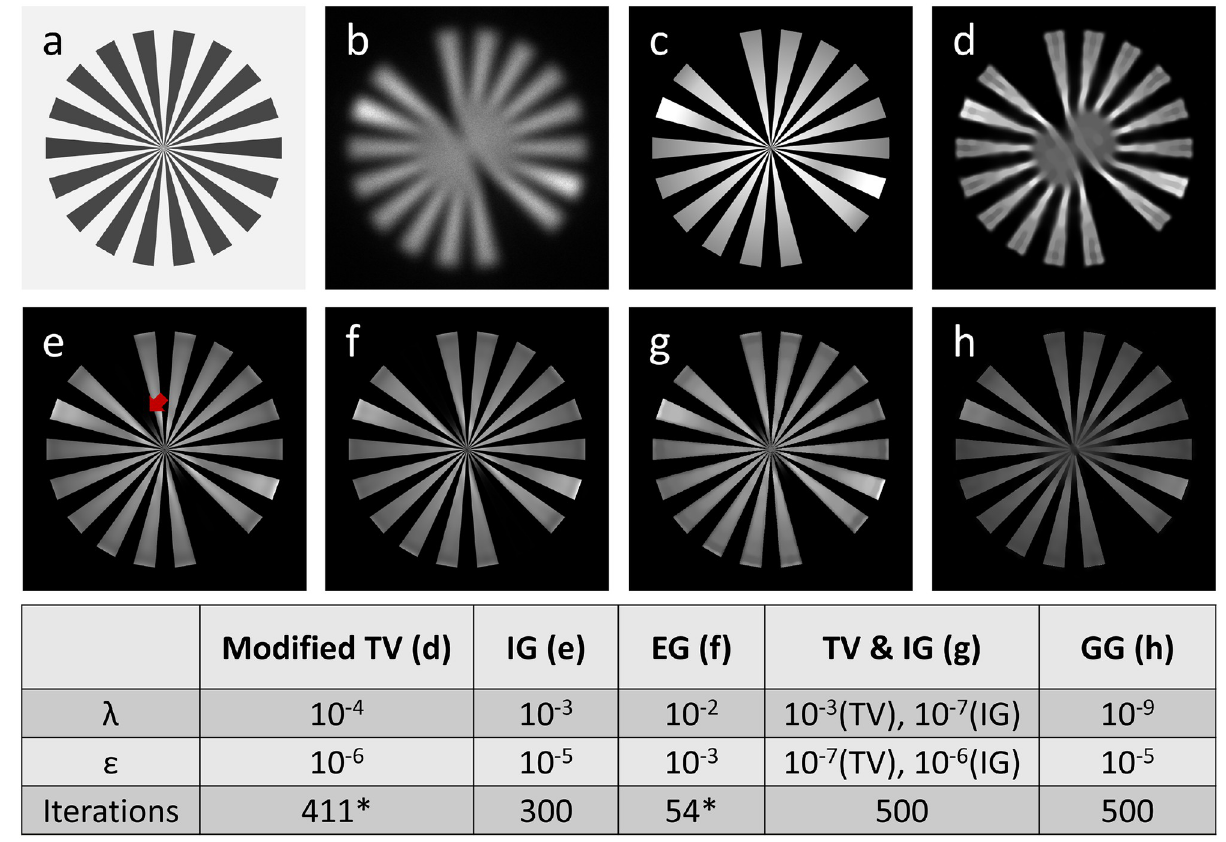
Fig 1. Deconvolution with the simulated example. A comparison of the results of different deconvolution methods. a) The simulated LM image with Poisson noise correlates with the EM image. b) The simulated EM image correlates with the LM image. c) The ground truth of the LM emission. d)—h) Results of modified total variation, intensity-guided, entropy-based intensity-guided, combined total variation with intensity-guided and gradient- guided deconvolution.